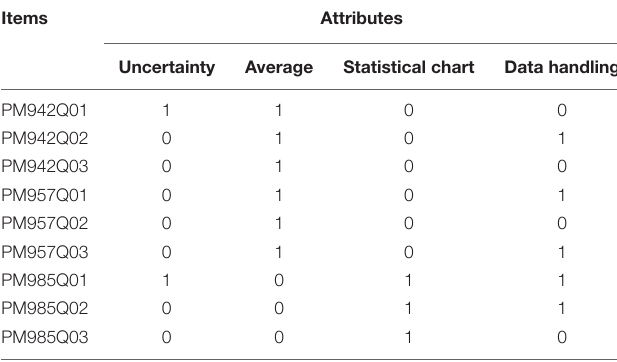
TABLE 2 | Q-matrix of 9 test items in